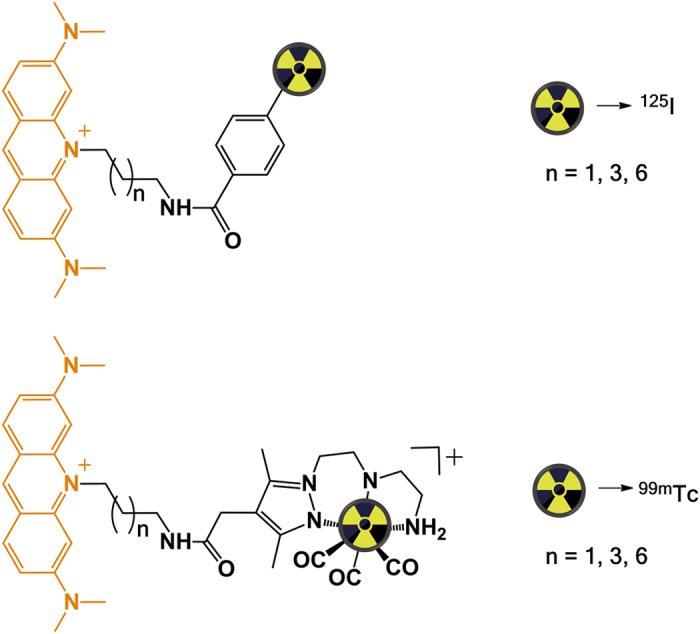
Schematic drawing of the 125I- and 99mTc-labelled AO derivatives studied.AO is represented in orange.